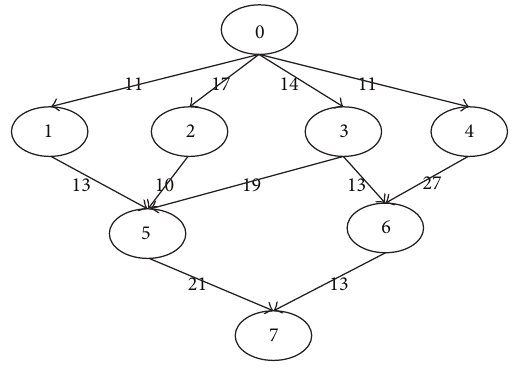
Figure 1: A simple DAG 𝐺